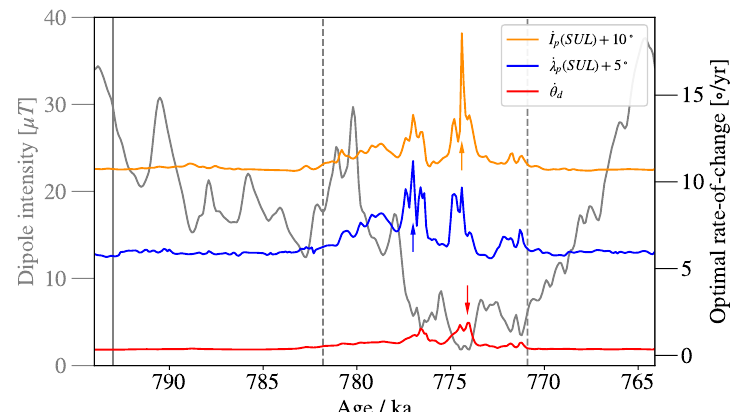
Figure 7. Time series of instantaneous optimal ˙ I ( SUL ) , ˙ λ p ( SUL ) and ˙ θ d as calculated with the IMMAB4 field model as the background and for T 0 = 13 km/y. For the ease of inspection, the coloured curves were offset by the indicated amount, and the epochs of maximum optimal variations are indicated by arrows. The grey curve indicates the intensity of the dipole field as predicted by the IMMAB4 model. The vertical dashed lines represent the boundaries of the reversal period according to [21], and the vertical continuous line indicates the epoch to which the plots on the left column of Figure 8